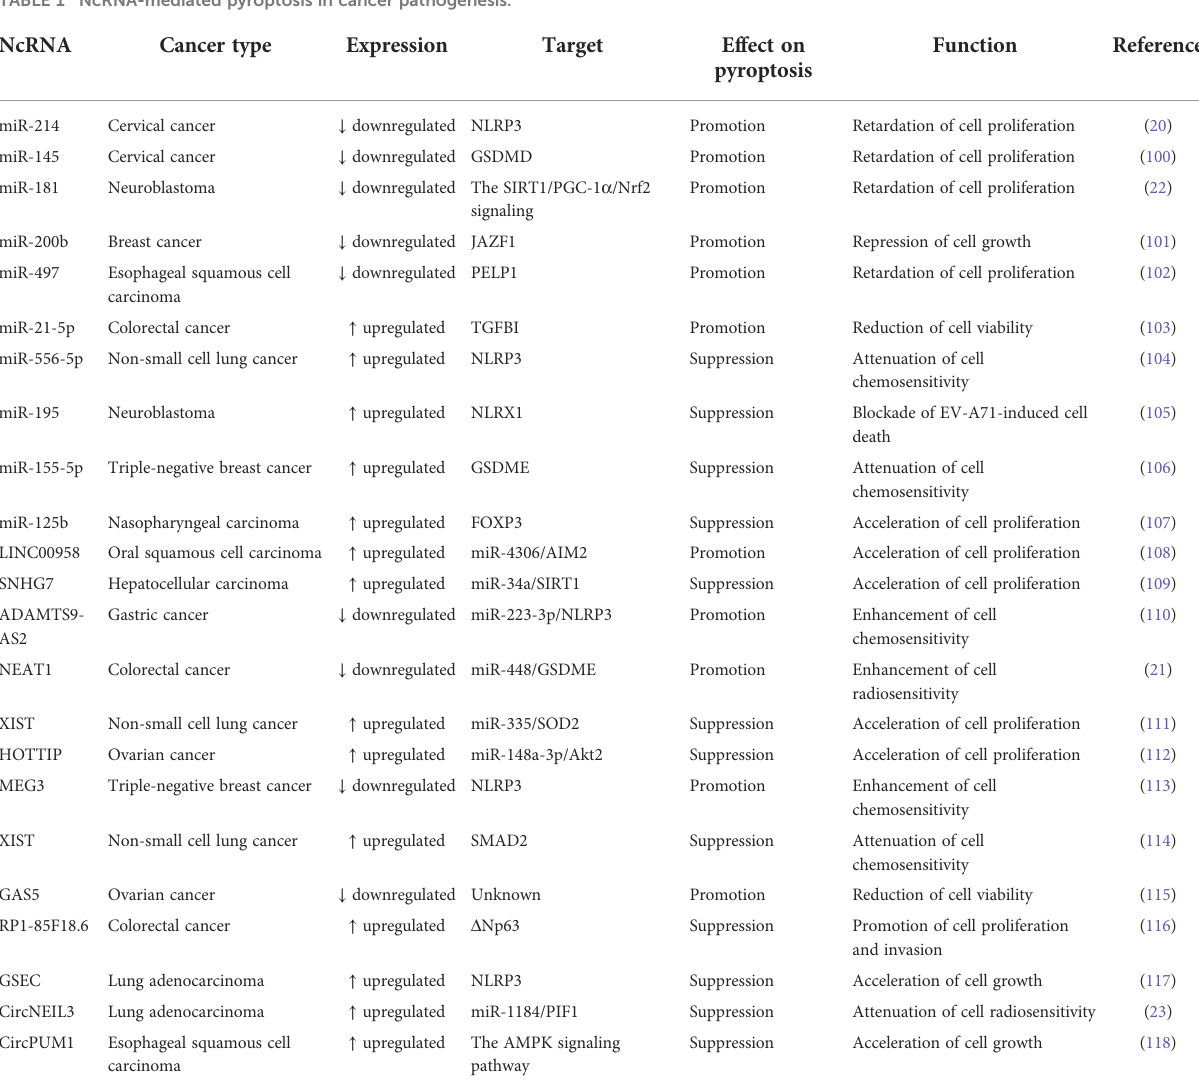
TABLE 1 NcRNA-mediated pyroptosis in cancer